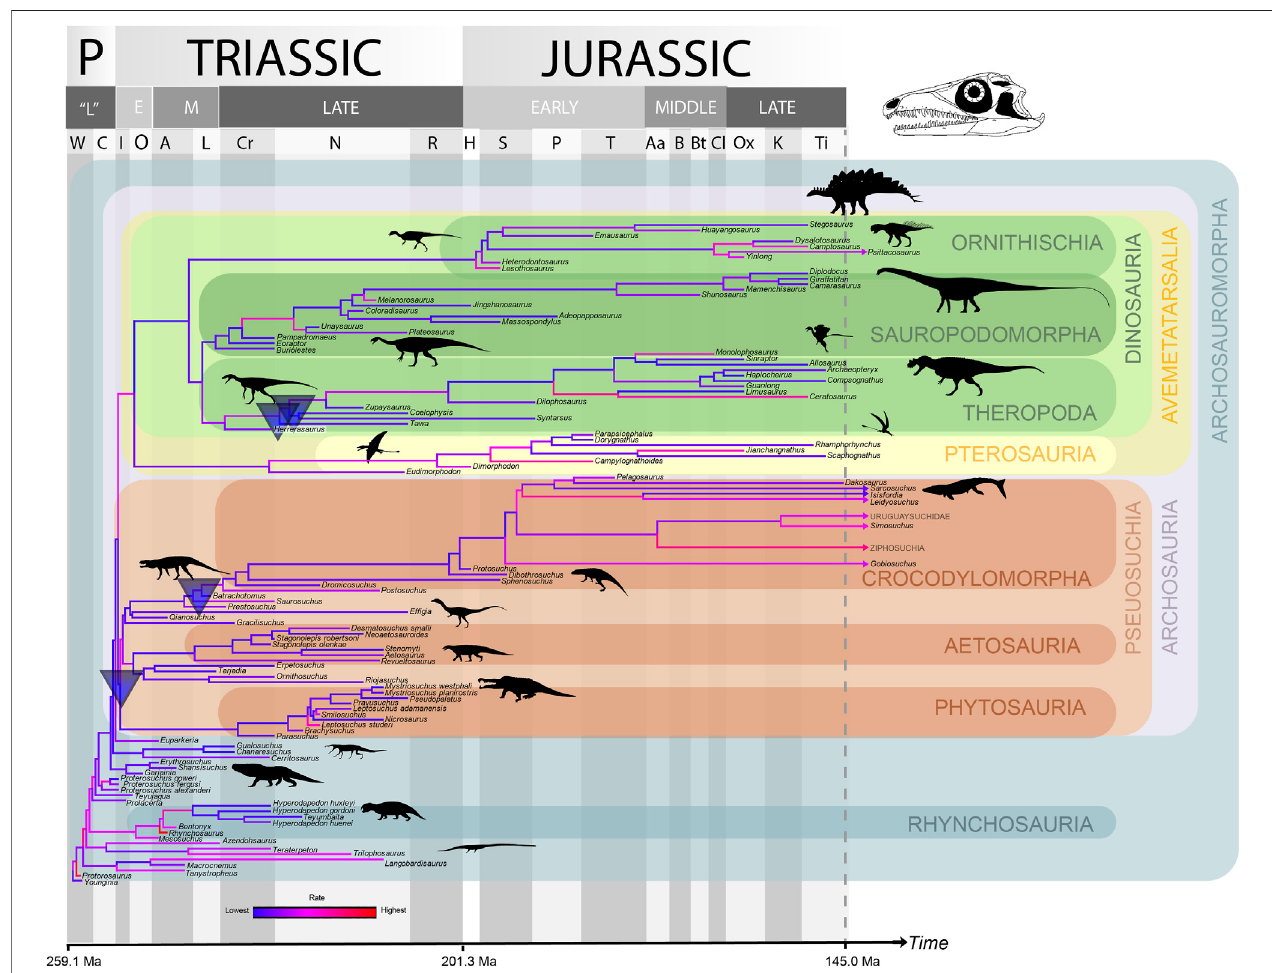
FIGURE10| Resultsforevolutionaryrateandrateshiftanalysisfor2DgeometricmorphometricshapeforthecraniumofarchosauromorphsfromthePermian-Late Jurassic for a single randomly chosen, range-dated tree from the treeset of 1,000 trees. Results differed across trees, especially with range dating — full results are reportedinthetextand giveninthe Supplementary Material .Rates tendedtobehigherinitiallyand slowdown withinclades, withsign fi icantdownshiftsnearthebase ofclades,oftenprecedingupshiftsslightly “ stemward ” ofthese(inothertreesfromthesample).Redderbranchcolorsindicatehigherratesandbluerbranchcolors lower rates. Blue downward arrows indicate signi fi cant decreases in rate. Prolacerta skull modi fi ed after Ezcurra (2016); all silhouettes taken from www.phylopic.org.